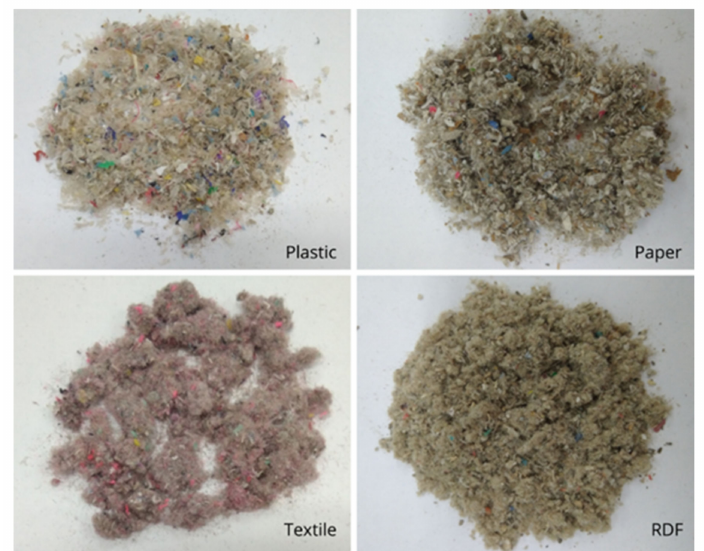
Figure 3. RDF and its fractions before the